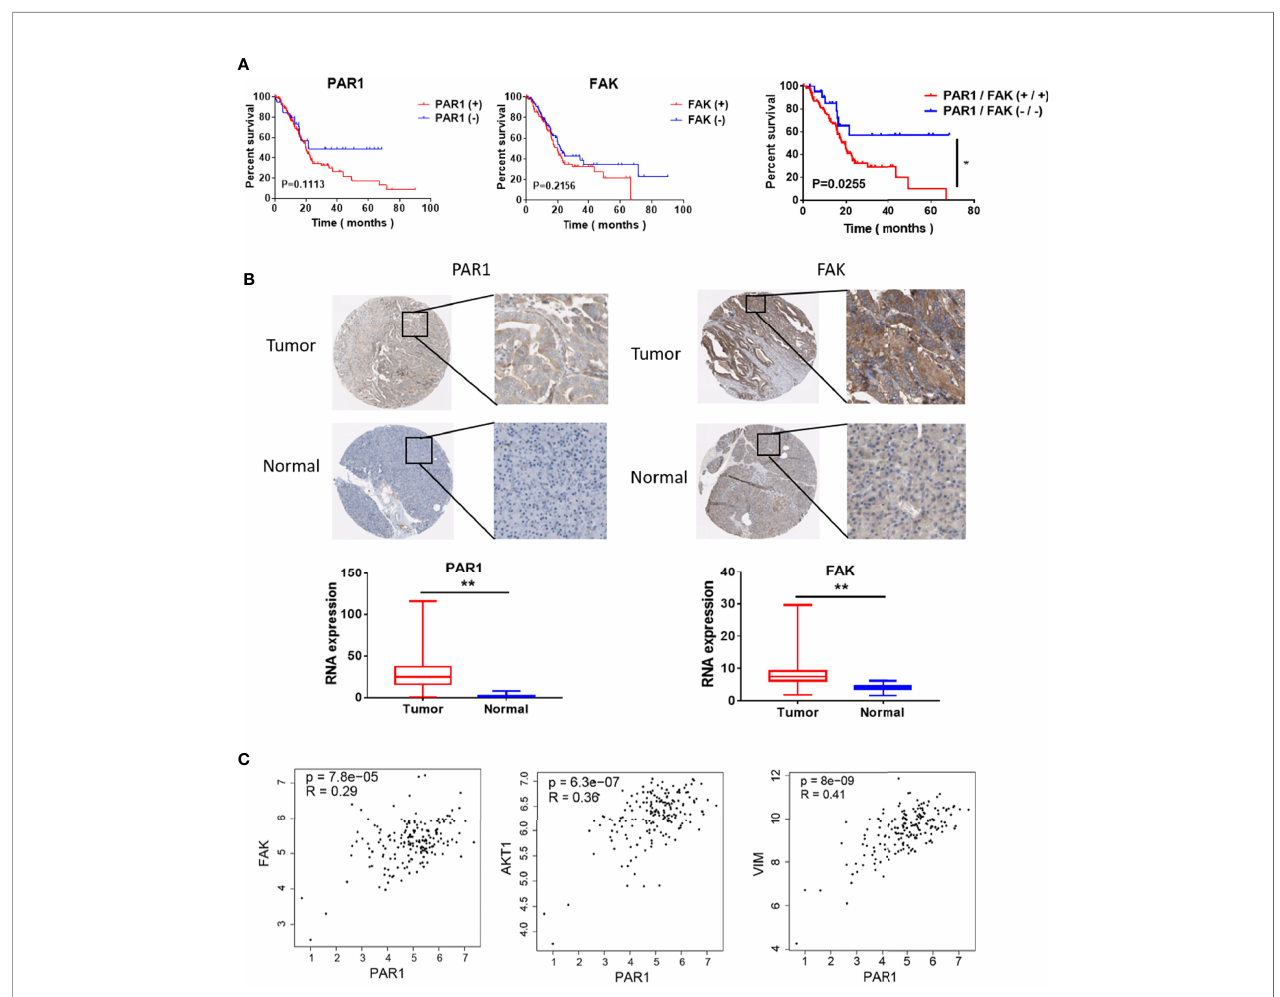
FIGURE 3 | Effect of PAR1 on the pancreatic cancer prognosis. (A) Effect of PAR1 and FAK on pancreatic cancer prognosis. Data were obtained from TCGA database. (B) PAR1 and FAK expression levels in normal pancreatic tissues and pancreatic cancer tissues. Data were obtained from the Human Protein Atlas online database. (C) The correlation analysis between PAR1 and FAK, AKT, and VIM expression of TCGA pancreatic cancer samples from GEPIA (http://gepia.cancer-pku.cn/). Data are shown as the mean ± SD (* P < 0.05, ** P <